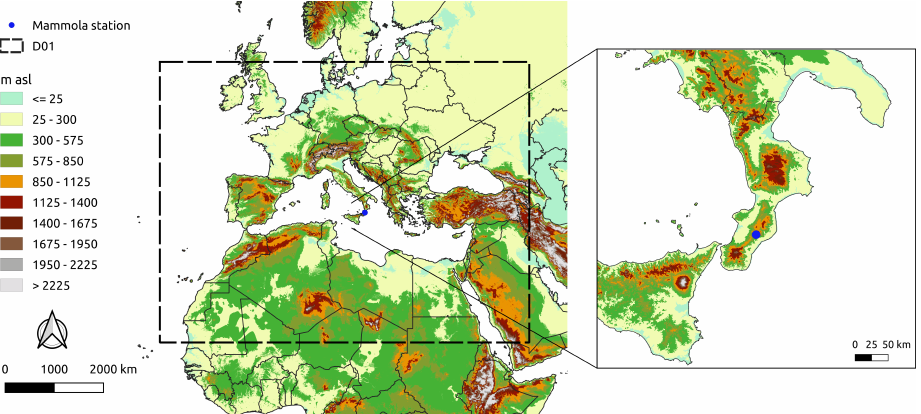
Figure 1. Geographical location of the rural regional background Mammola station (blue point) and Weather Research and Forecast (WRF) domain (dashed